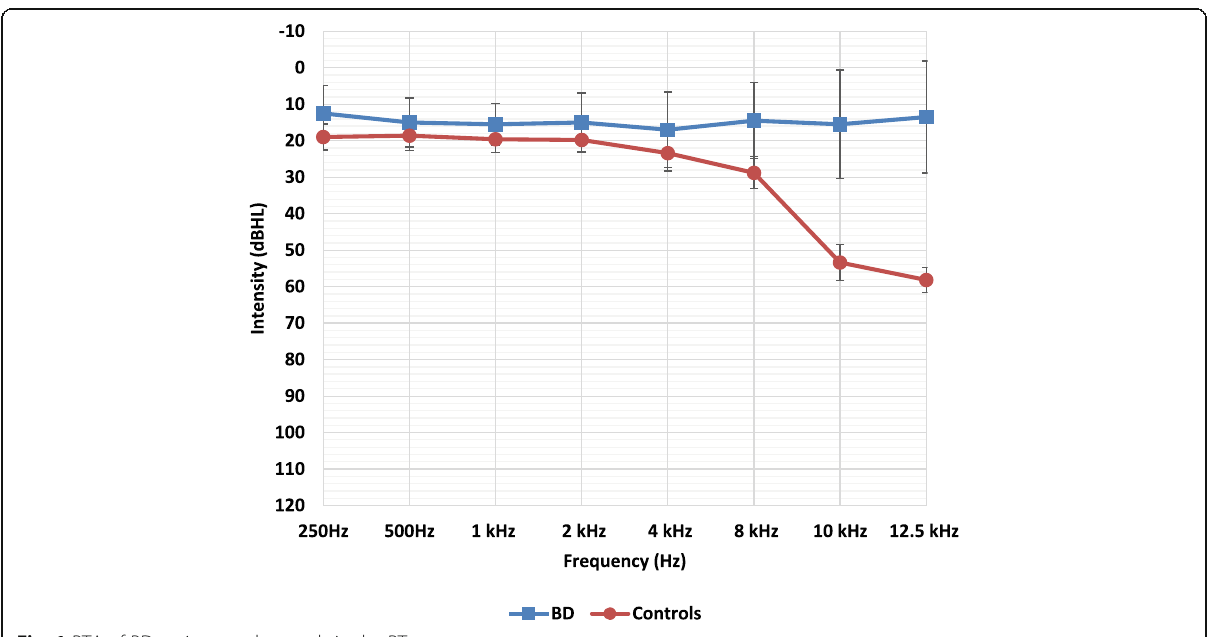
Fig. 1 PTA of BD patients and controls in the RT ears